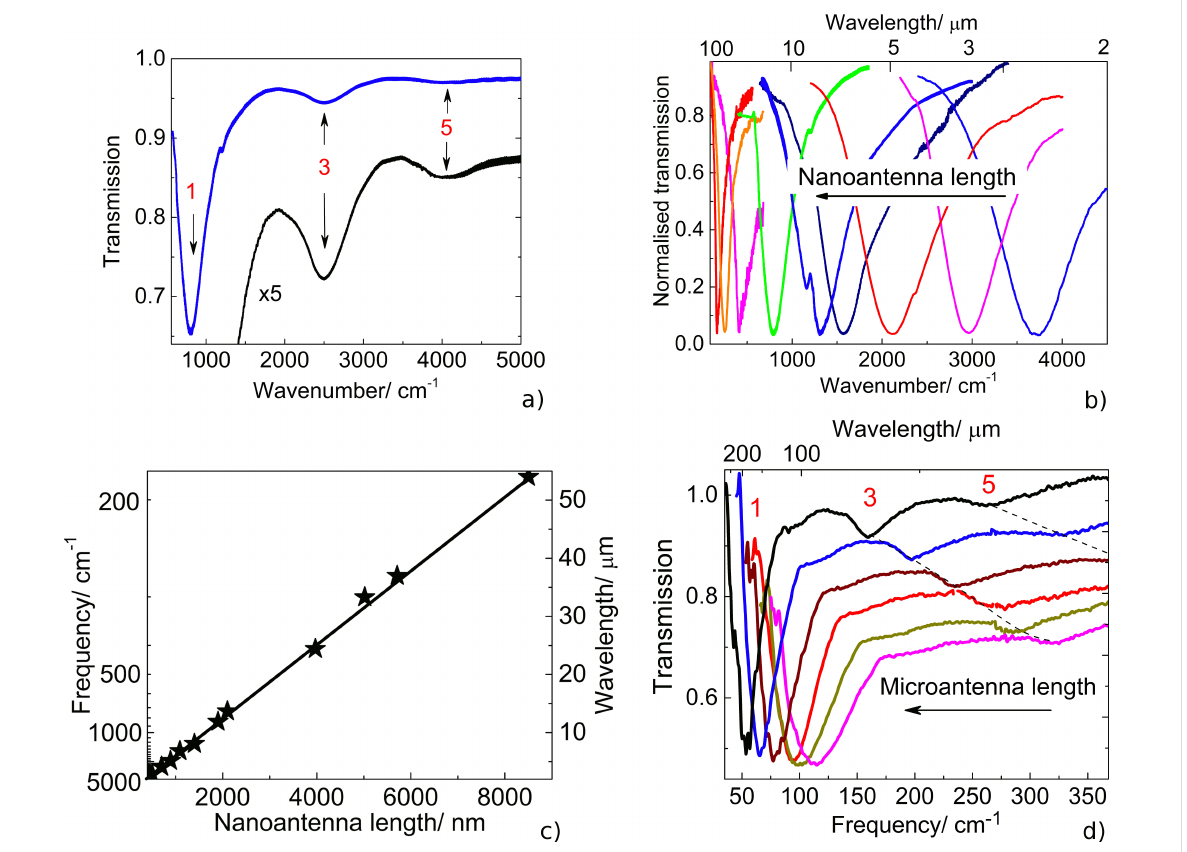
Figure 2: a) Typical IR transmission spectrum for the array of nanoantennas with a length of 1800 nm. The lower curve (black, labeled as ×5) shows the magnified IR spectrum (blue) to emphasize the higher-order plasmon modes. b) Normalized IR transmission spectra of linear antennas with differ- ent lengths (adopted from [12]). c) LSPR energy in nanoantenna arrays fabricated on bare Si surfaces as a function of the nanoantenna length (adopted from [12]). d) Normalized IR transmission spectra of the fabricated microantennas with different lengths (14.7; 16.4; 17.8; 20.2; 24.3; 30.6 µm). The numbers in the figures indicate the order of the LSPR modes.